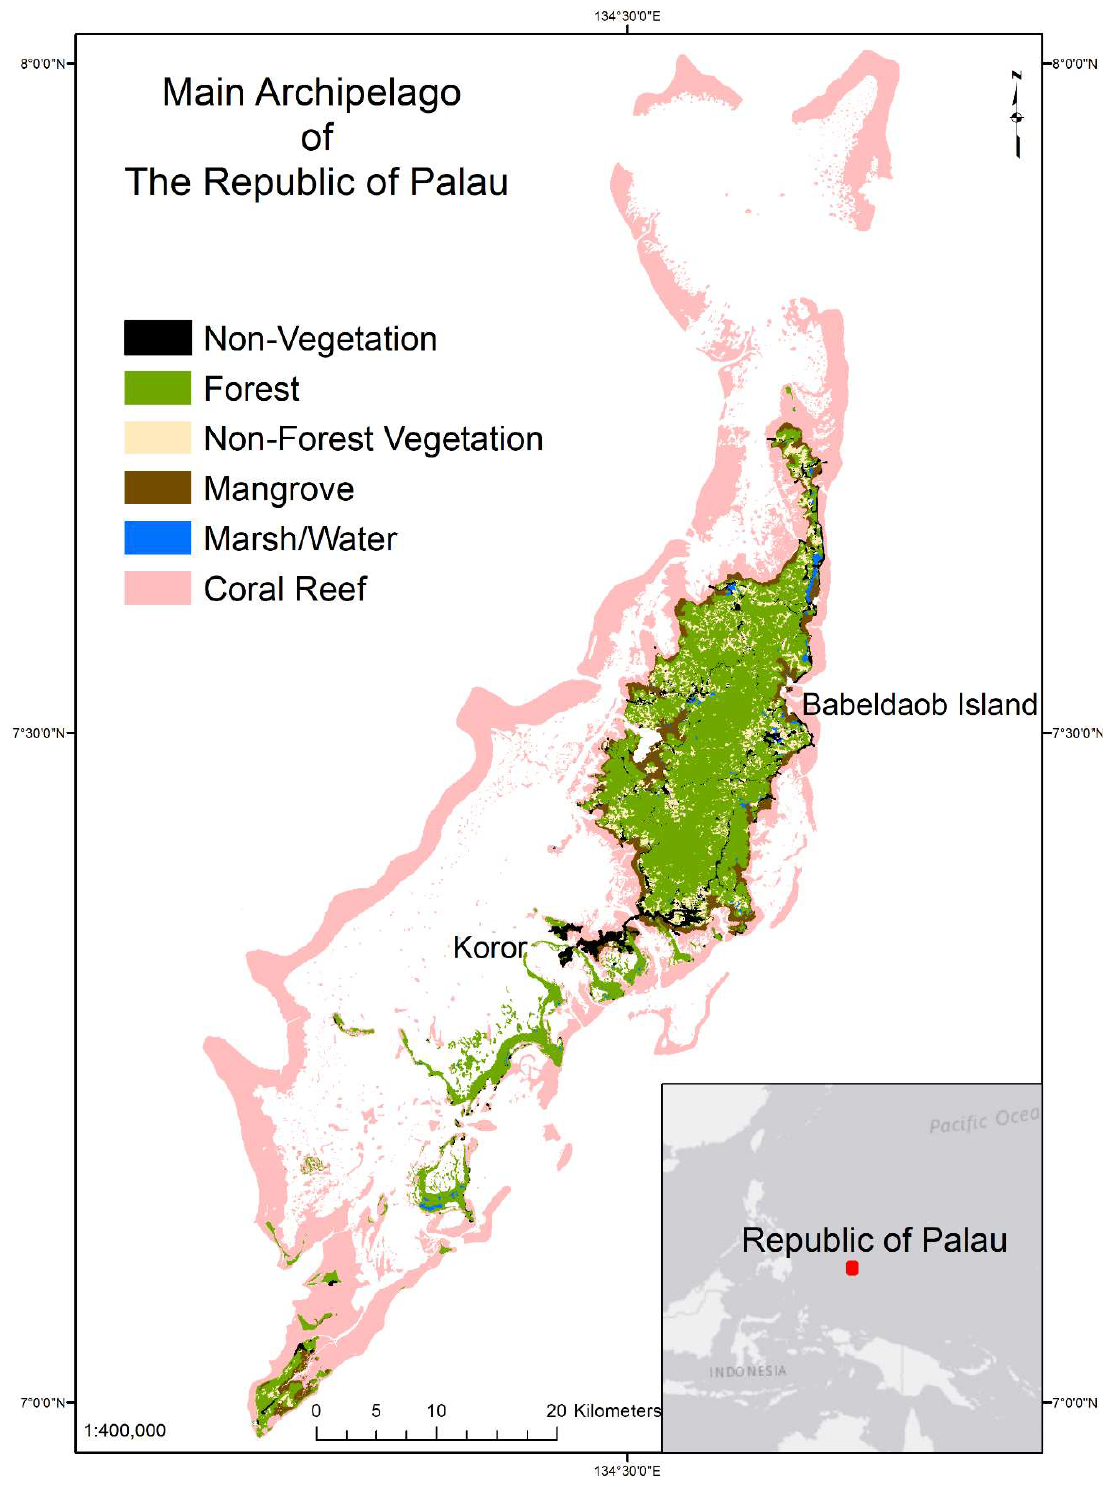
Figure 1. Palau’s main archipelago showing Babeldaob Island with main vegetation types and extent of coral